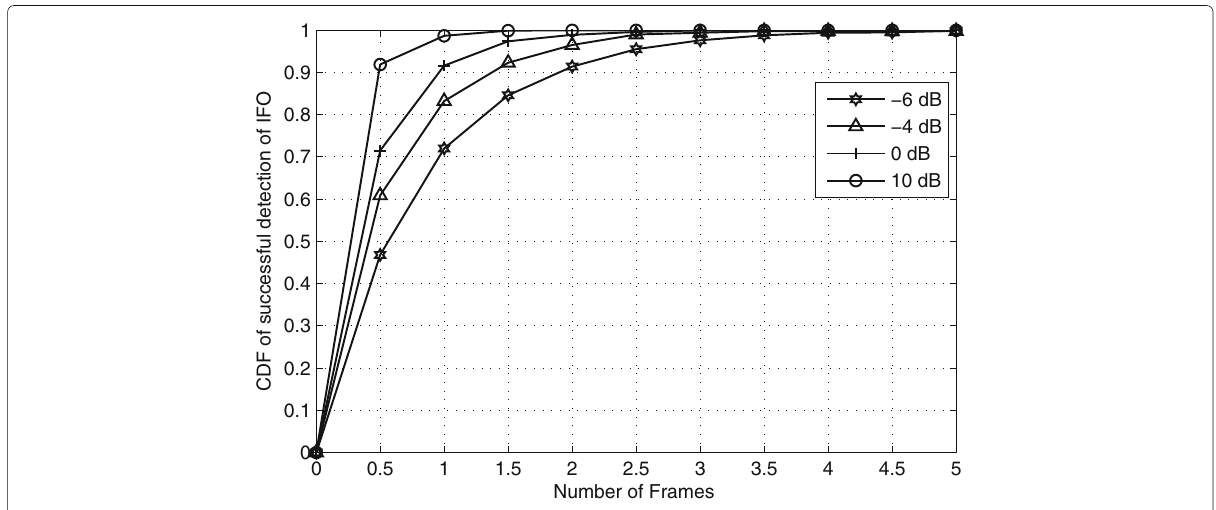
Fig. 9 CDF of IFO successful